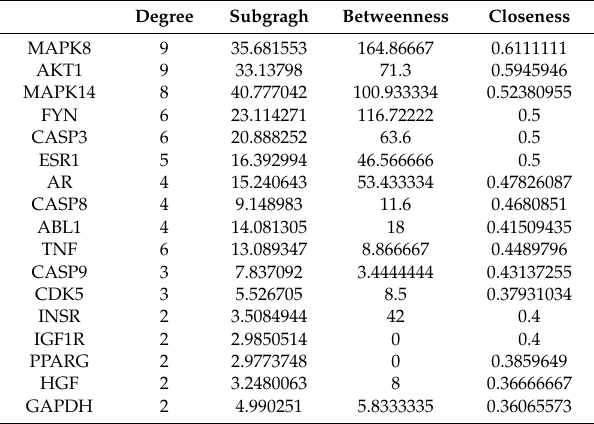
Table 2. Topological parameters of the targets. Degree Subgragh Betweenness Closeness